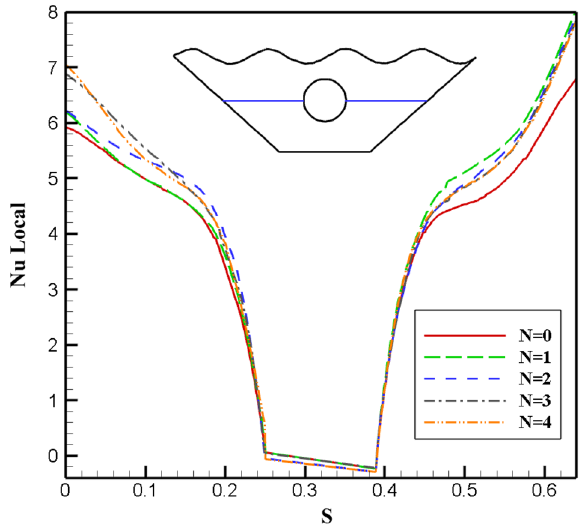
Figure 7. Local Nu number plot for different number of waves (N).